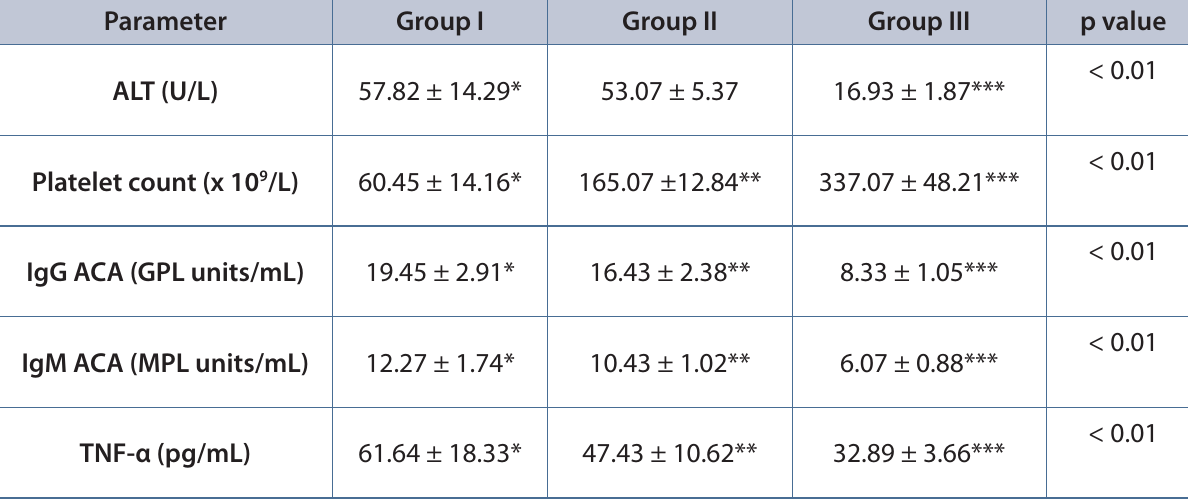
Table 2. Laboratory data of thrombocytopenic patients